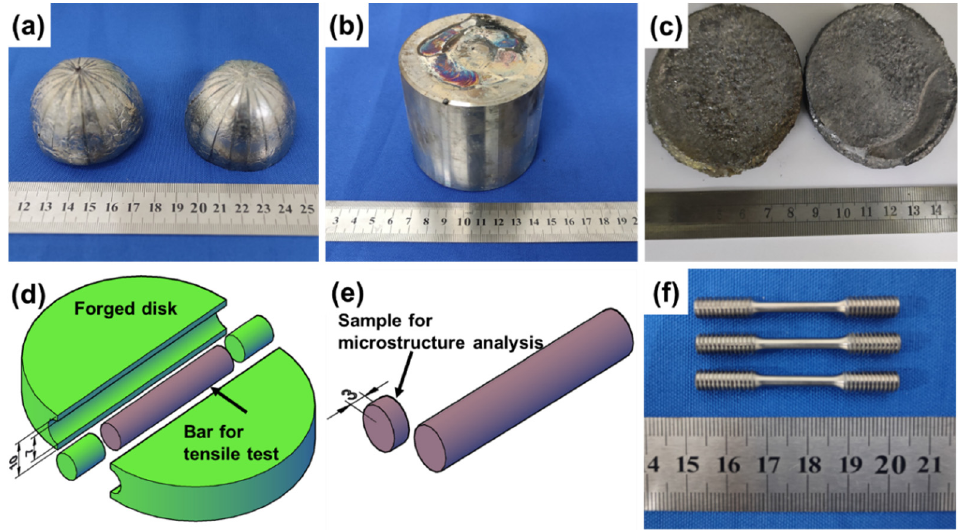
Figure 1. The processing samples of TiAlMn alloy: ( a ) ingots, ( b ) canned-forging specimens, ( c ) forged disks, ( d ) sampling position for tensile tests, ( e ) sampling position for microstructure analysis, ( f ) tensile specimens.